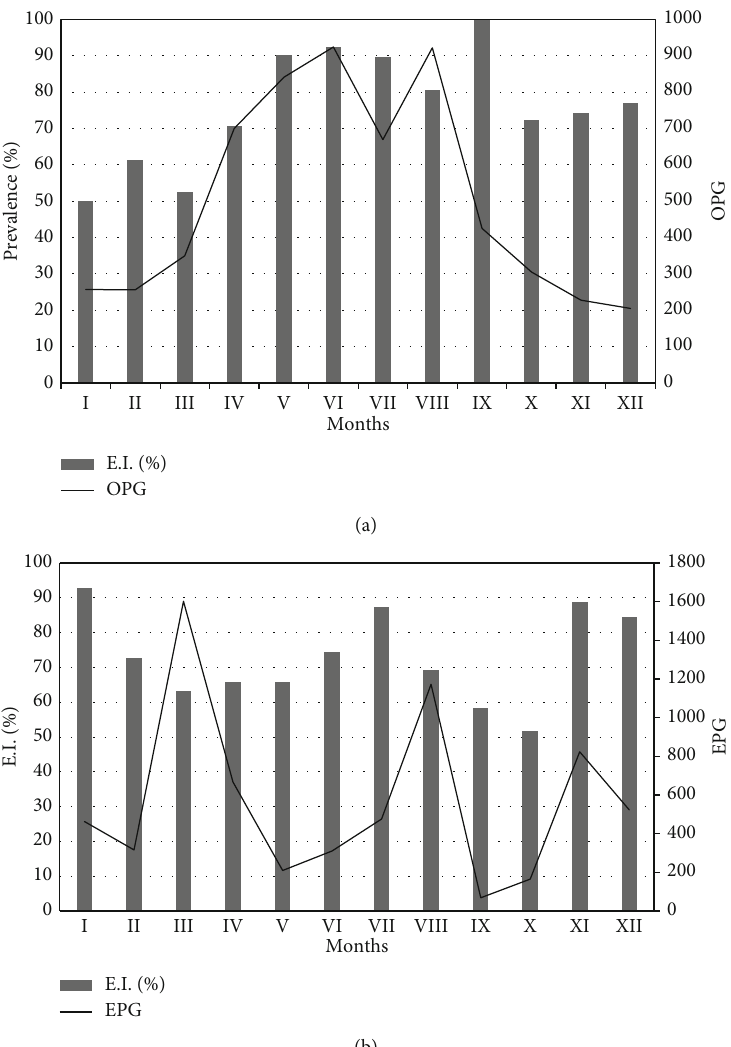
Figure 1: Prevalence and intensity of infection of mou fl ons with Eimeria protozoans (a) and gastrointestinal nematodes (b) in annual